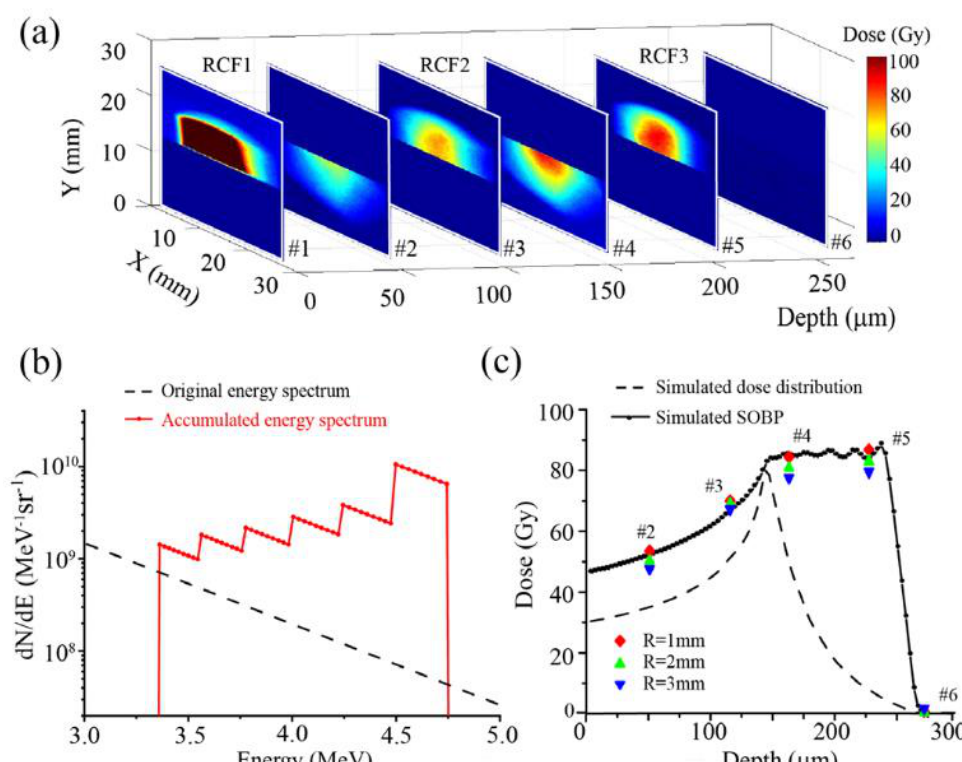
Figure 5. Production of a spread-out Bragg peak with accumulated proton shots at different energies. ( a ) Dose distributions at different depths recorded on the RCF stack. The depth shift of the Bragg peak, due to the aluminum foil, is converted to an equivalent depth for the RCF film. ( b ) The black dashed curve is the original exponentially decaying energy spectrum measured directly behind the foil target in the acceleration chamber. The red curve is the total spectrum of proton beams accumulated to form the SOBP on the irradiation platform. ( c ) Comparison of the experimental results with a simulated depth profile. The black curve is the accumulated dose distributions of all 203 shots of protons, as simulated using SRIM. The red, green, and blue dots represent the average doses within a 1, 2, and 3 mm radius of the beam center, respectively, at the different depths obtained in the experiment. The black dashed curve represents the expected dose profile if we were to use the exponentially decaying energy spectrum directly. The dose coordinate of the black dashed curve is magnified for ease of comparison, while the shape of the curve is not changed.